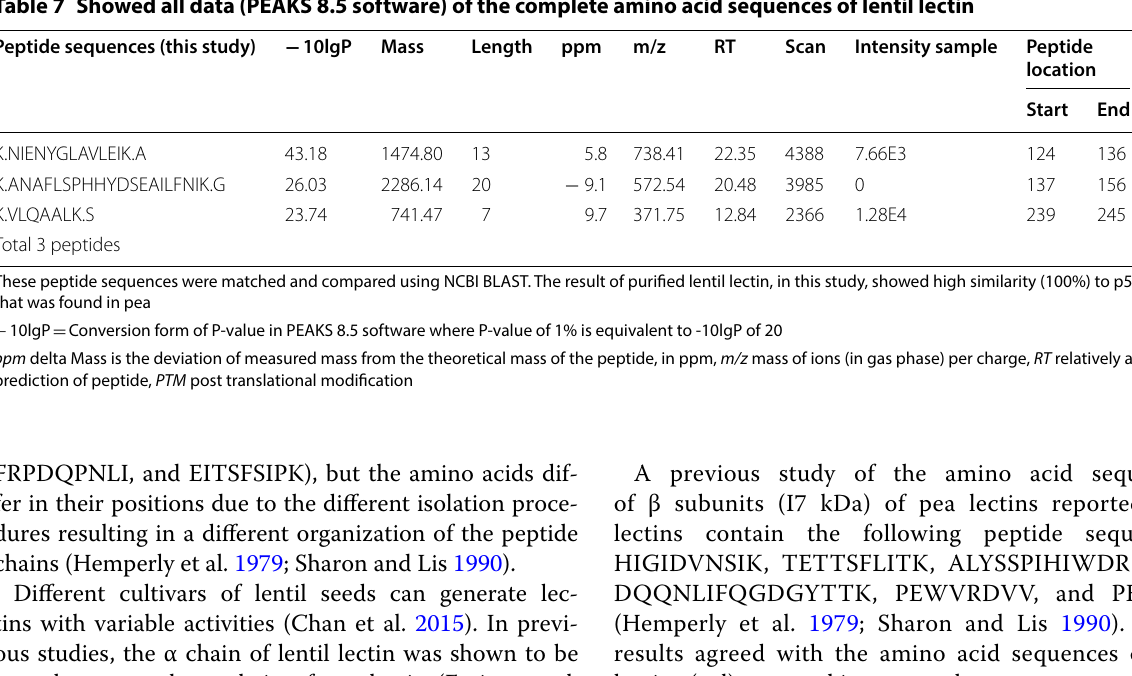
Table 7 Showed all data (PEAKS 8.5 software) of the complete amino acid sequences of lentil lectin Peptide sequences (this